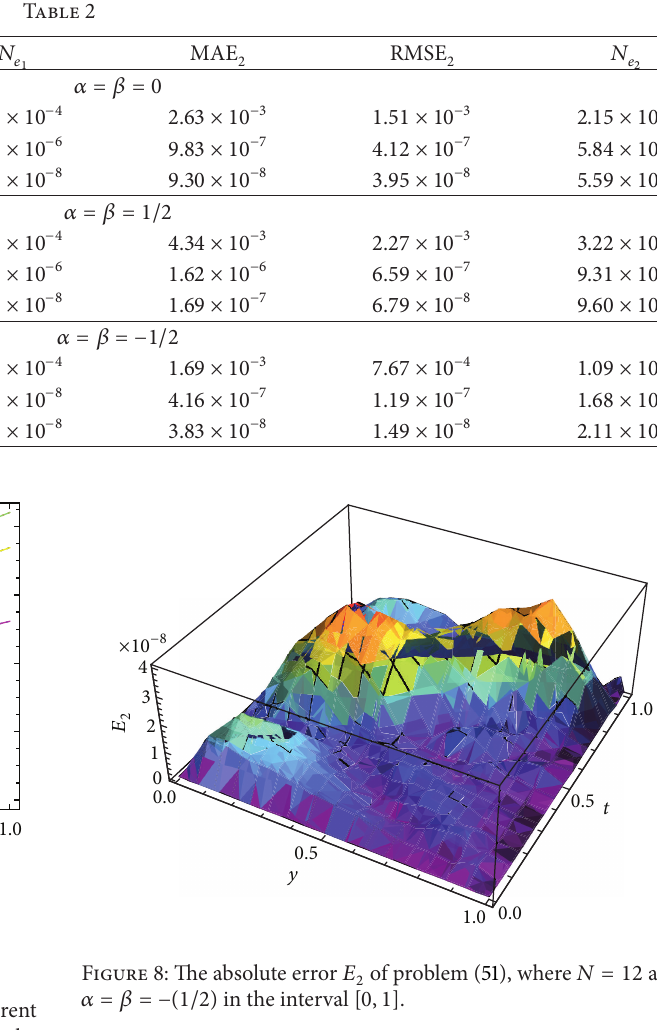
Figure 6: The approximate ̃ V and the exact V solutions for different values of 𝑦 = 0.0 , 0.5, and 0.9 of problem (45), where 𝑁 = 16 in the interval [−𝜋,𝜋] .